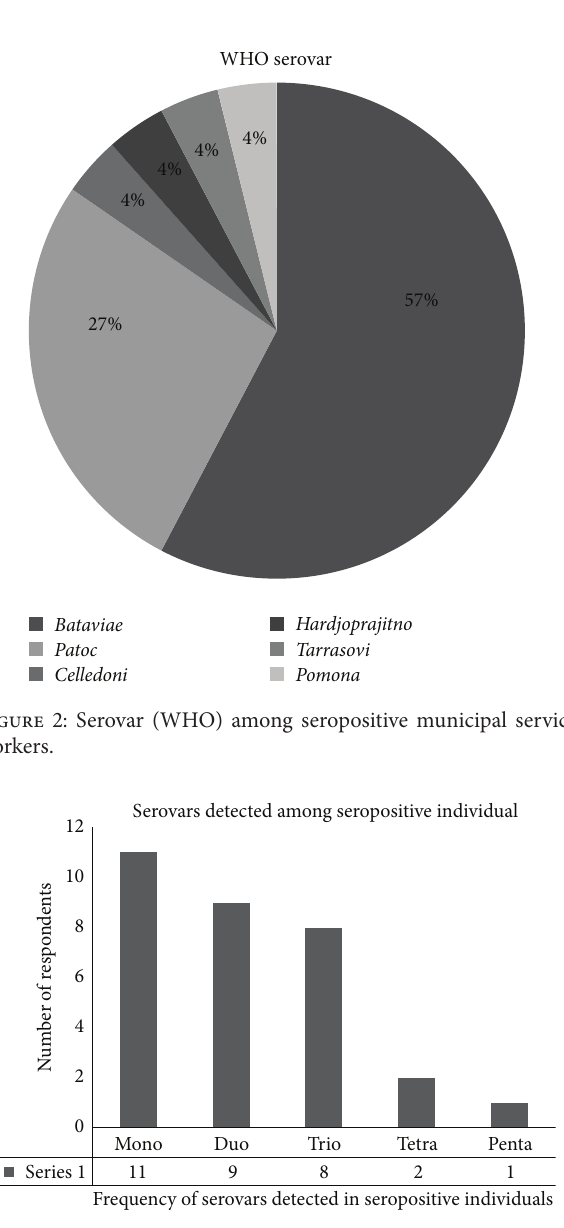
Figure 3: Frequency of serovars in seropositive samples.